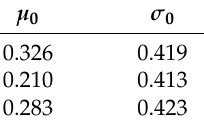
Figure 6. Comparison of Equation (3) with the experimental data. ( a ) upper nappe; ( b ) lower nappe; ( c ) side nappe. Table 2. Values of μ 0 and σ 0 .